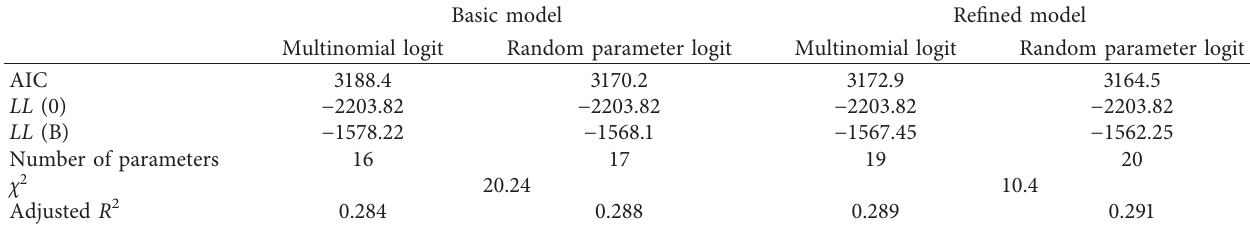
Table 3: Goodness-of-fit measures for multinomial and random parameter models.